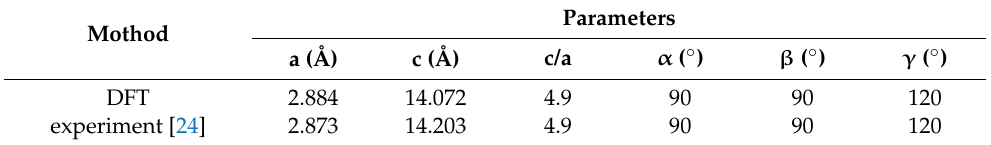
Table 1. Cell parameters of NCM811-Intermediates obtained by different methods.